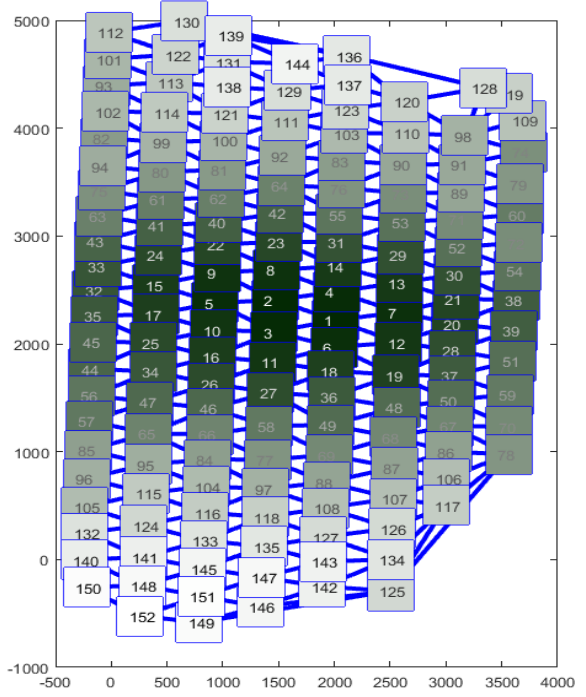
Figure 5. The region growing sequence of images